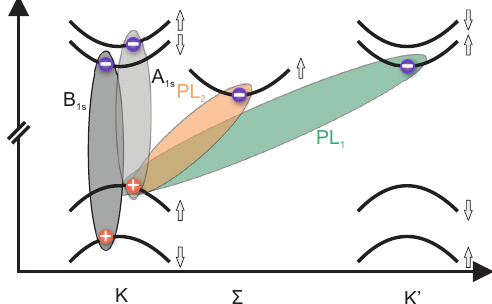
Figure 5. Schematic representation of the exciton formed by holes (red spheres) residing in the K valley and electrons (blue spheres) residing in K , K (cid:48) and Σ valleys that are interpreted to originate B 1 s , A 1 s , PL1 and PL2,